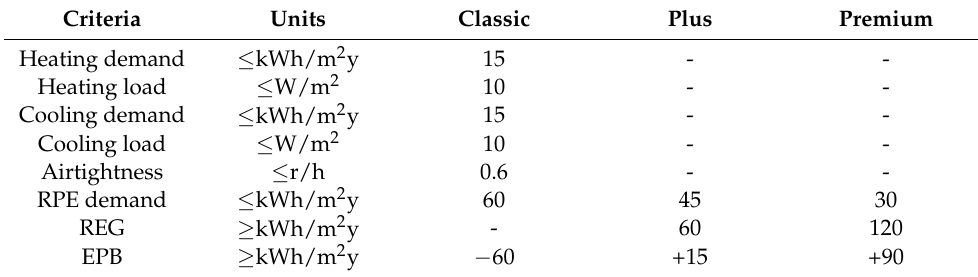
Table 3. Passivhaus standard criteria comparative for the Active Building 1 (AB1+PH/DGC